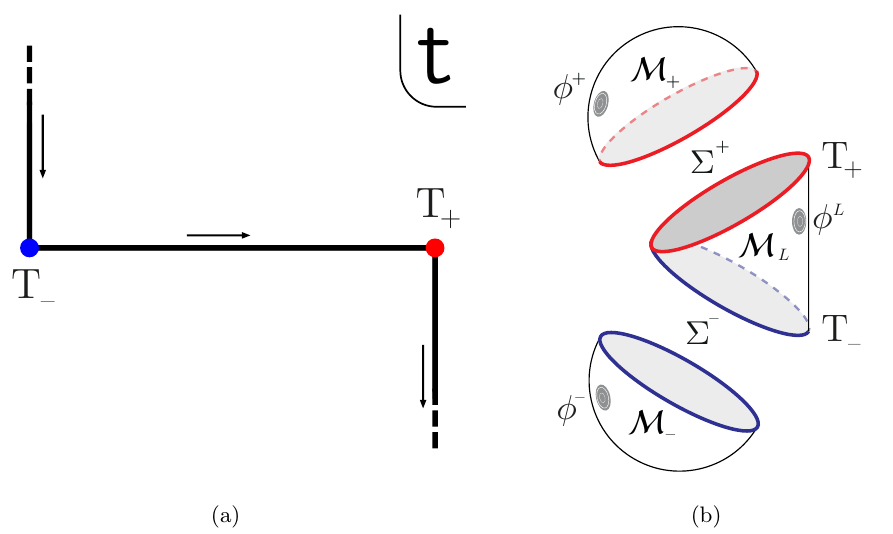
Figure 2 . (a) In-Out path in the complex t -plane (b) Holographic SvR dual set-up in Poincare